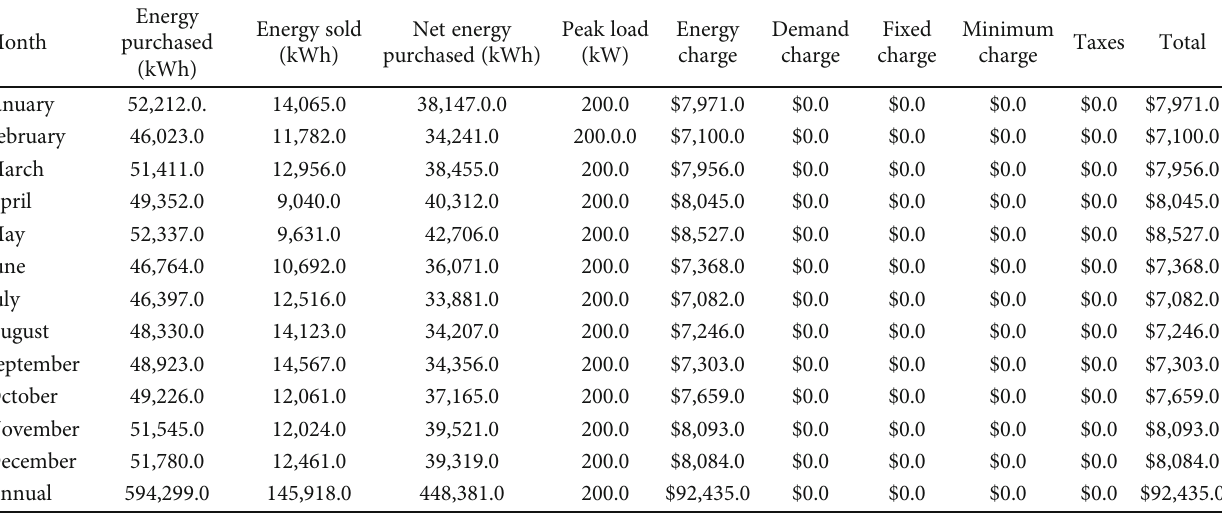
Table 5: Utility monthly summary — proposed system.